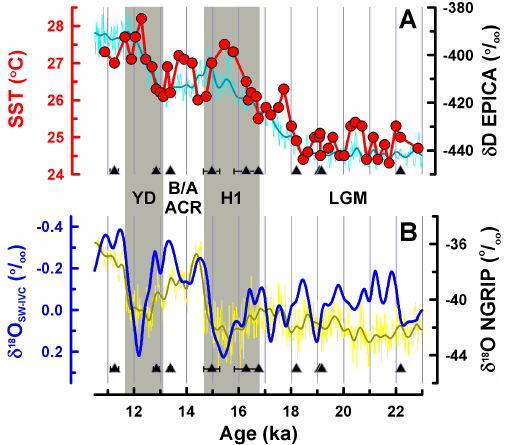
Figure 4. Geochemical proxy records of MD05-2925. (a) SST (red circles and line) and (b) δ 18 O SW IVC (blue line) were recon- − structed with G. ruber Mg/Ca ratios and δ 18 O C . The cyan line de- notes the Antarctica EPICA (European Project for Ice Coring in Antarctica) deuterium isotope record (Stenni et al., 2003), and the yellow line is the Greenland ice core NGRIP (Northern Greenland Ice Core Project Members, 2004) oxygen isotope record. The su- perimposed dark cyan and dark yellow lines are the 200a smoothed records, respectively. Black triangles are AMS 14 C dates (Table 1). Vertical bars denote the H1 and YD